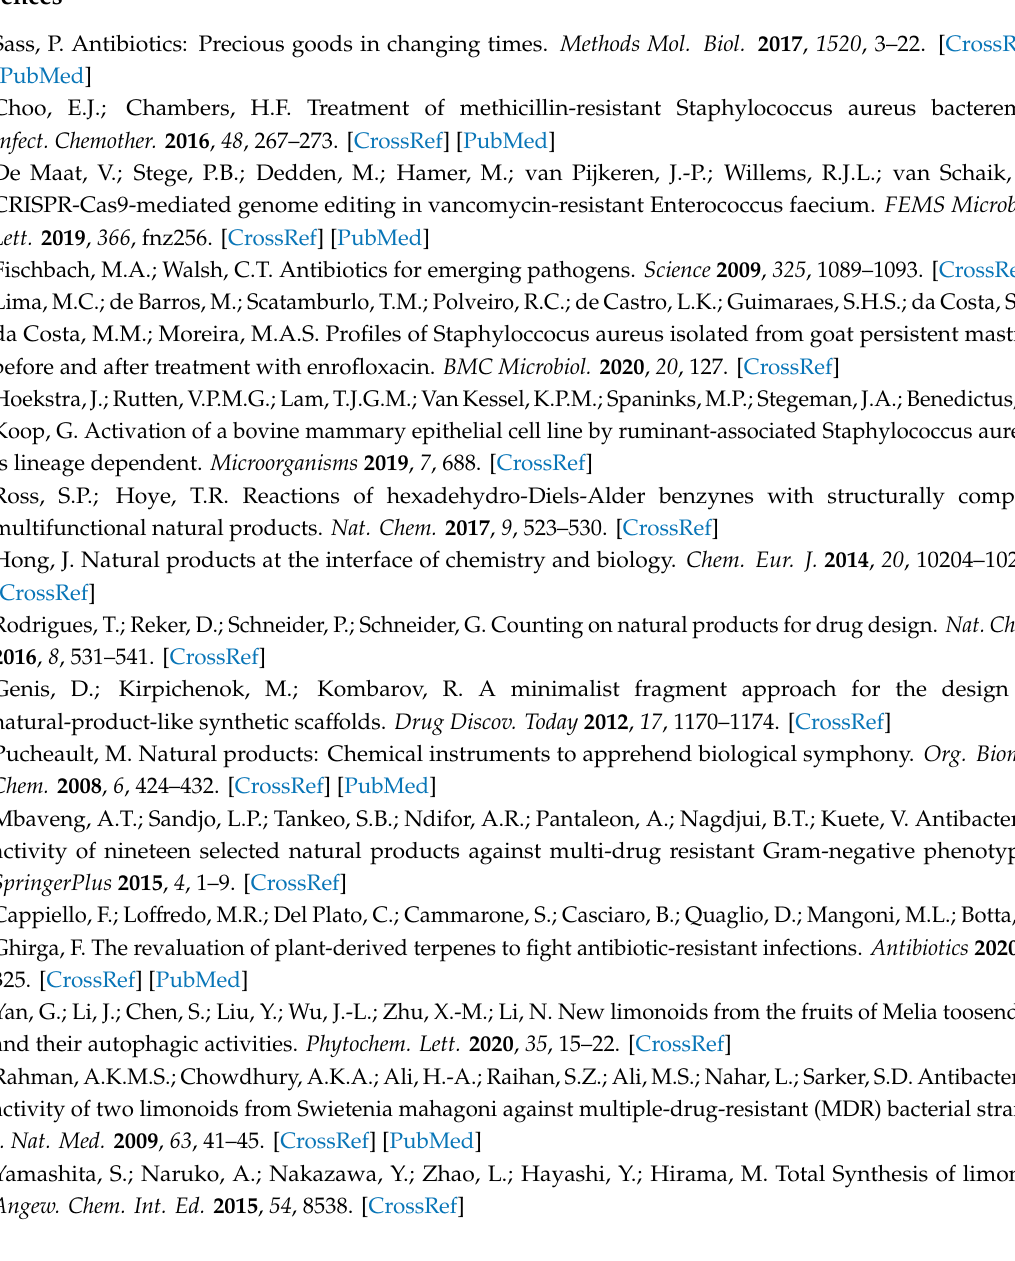
Figure S3. NMR and HRMS Spectra of ( ± )-3a, Figure S4. NMR Spectra of diastereoisomers ( ± )-4a and ( ± )-4b, Figure S5. NMR Spectra of diastereoisomers ( ± )-5a and ( ± )-5b, Figure S6. NMR Spectra of diastereoisomers ( ± )-6a and ( ± )-6b, Figure S7. HRMS Spectra of compounds 4, 5, and